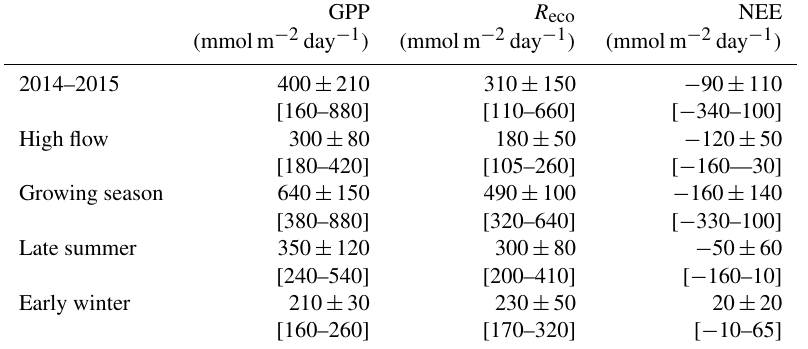
Table 3. Metabolic parameters (GPP, R eco and NEE) estimated at the Bilos plot with the eddy covariance techniques. Numbers represent the mean ± SD and the range (between square brackets) for the years 2014–2015 and for high-flow (January–March 2014 and February–March 2015), growing season (April–August 2014 and April–August 2015), late summer (September–October 2014 and September–October 2015) and early winter (November 2014–January 2015 and November–December 2015) periods. Positive NEE indicates an upward flux whereas a negative NEE indicates a downward flux; GPP is positive or zero and R eco is positive. NEE = R eco . − GPP. GPP R eco